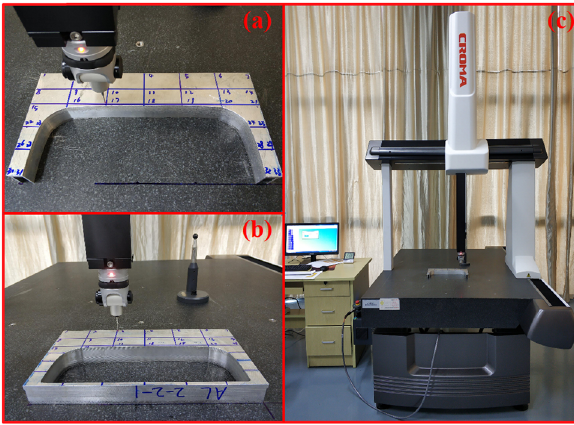
Figure 7: Deformation measurement of Specimen ( a ) A and ( b ) B, and ( c ) Coordinate measuring machine.